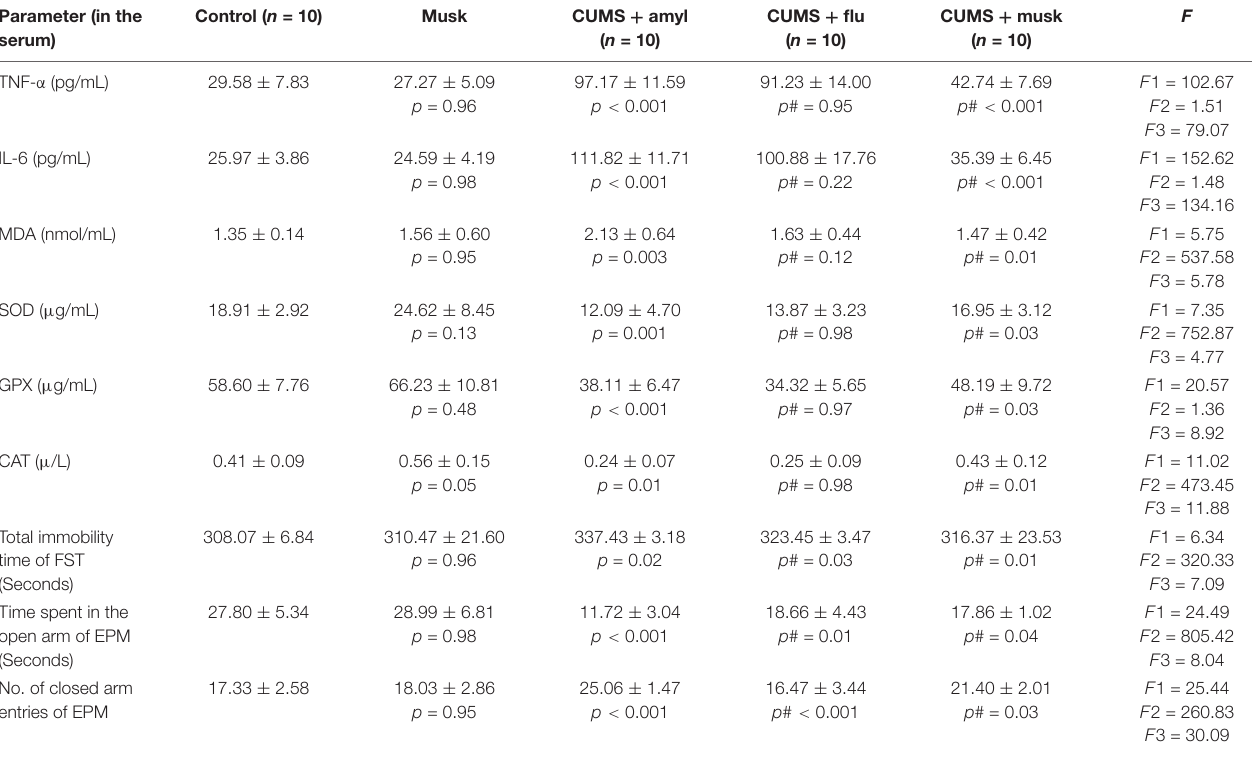
TABLE 2 | Effect of fluoxetine (Flu) and musk on the studied variables. Parameter (in the